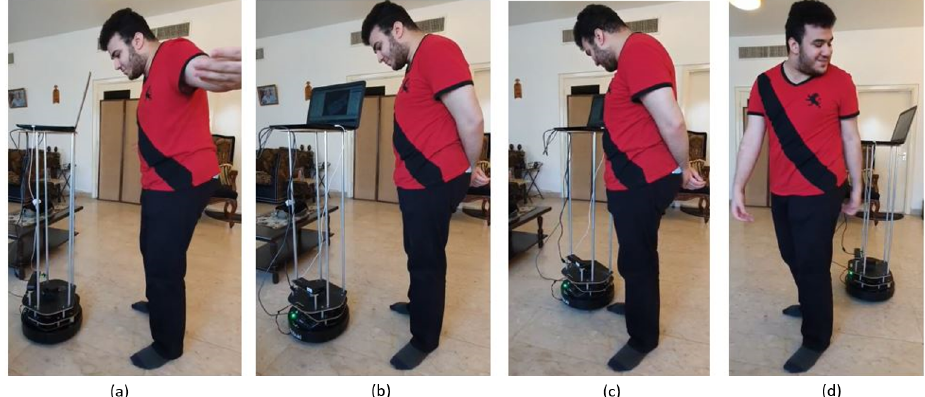
Figure 16. Collision avoidance algorithm testing results. ( a ) Shows the robot when detecting an obstacle by the front sensor, ( b – d ) show the robot avoiding the obstacle.